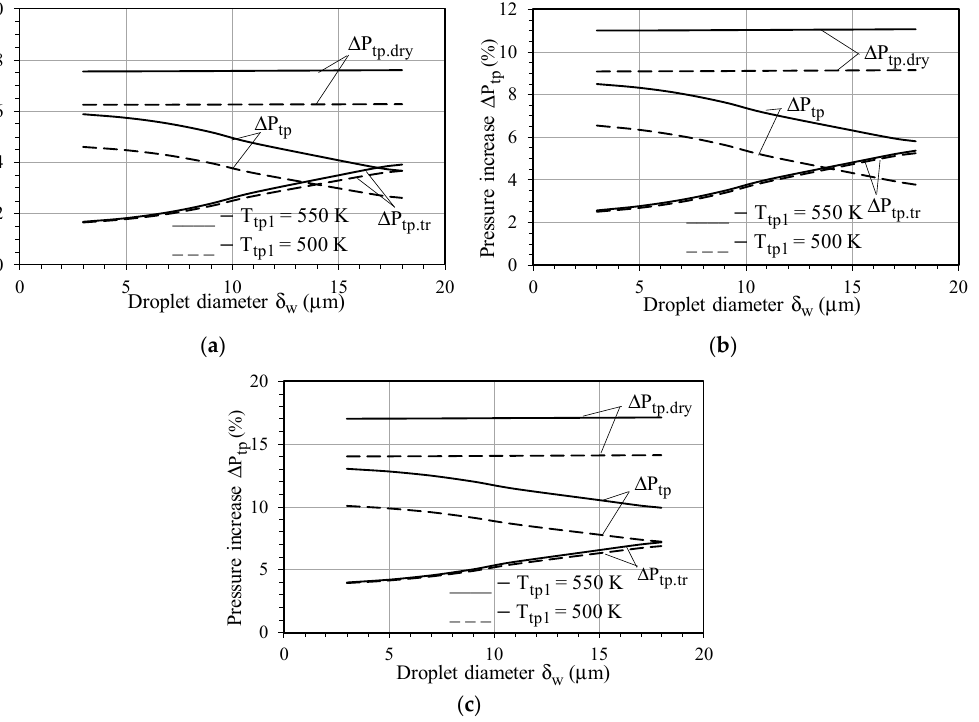
Figure 6. Dependences of the relative pressure increase, Δ P tp = P tp2 /P tp1 , on the droplet diameter, δ w , at different air temperatures and Mach numbers at the inlet: ( a ) Ma = 0.50, ( b ) Ma = 0.60 and ( c ) Ma = 0.74.